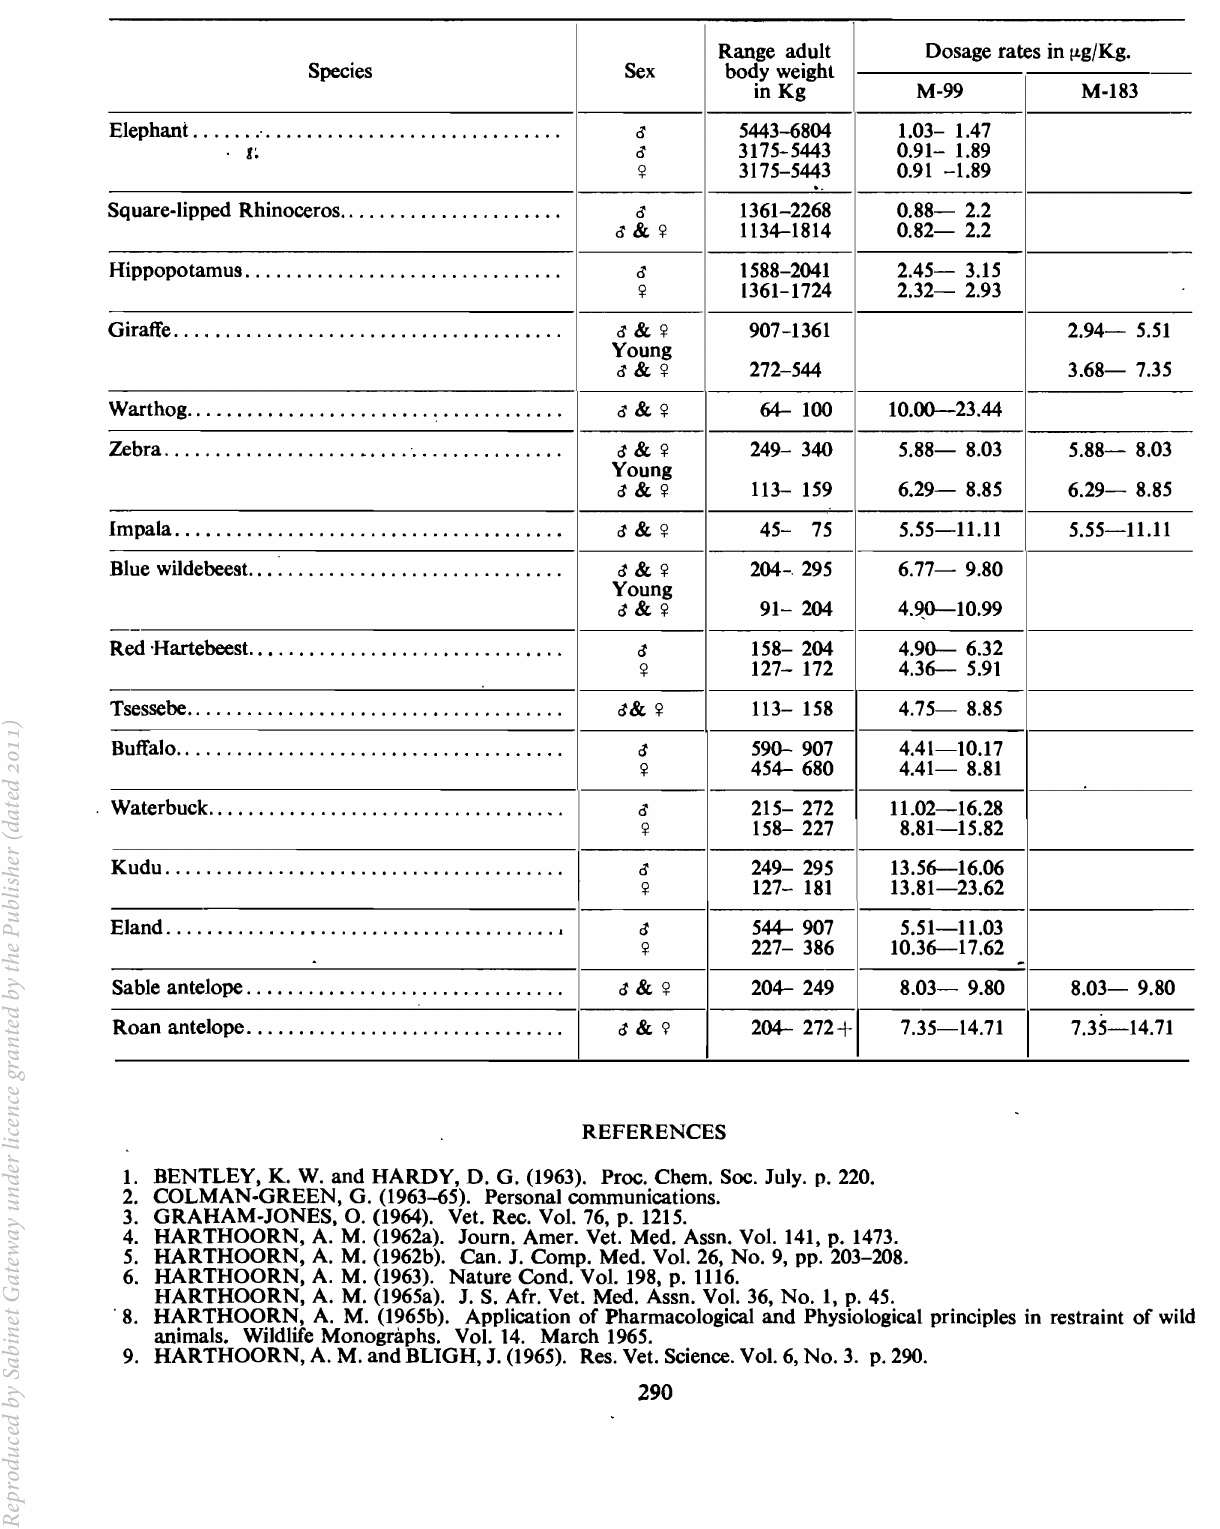
OPTIMUM DOSAGE RATES OF M-99 AND M-183 (IN MG/KG) IN NEUROLEPTANALGESIC MIXTURES FOR 16 SPECIES OF WILD HOOFED ANIMALS IN SOUTH AFRICAN NATIONAL